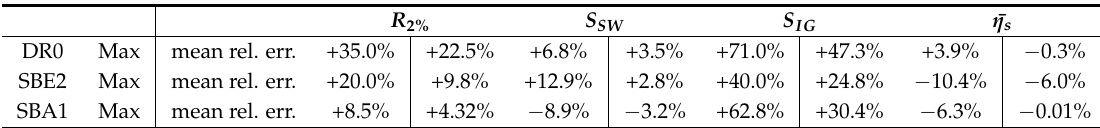
Table 7. Maximum and mean relative errors of the computed scenarios in comparison with the laboratory